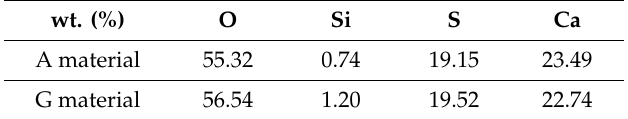
Table 3. Chemical composition of the plasterboards made of materials A and